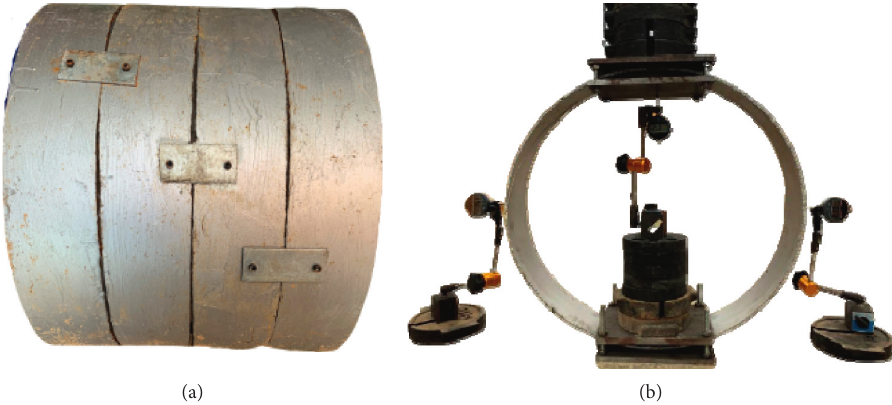
Figure 2: Shield tunnel model. (a) Segment structure. (b) Segment to pressure test.